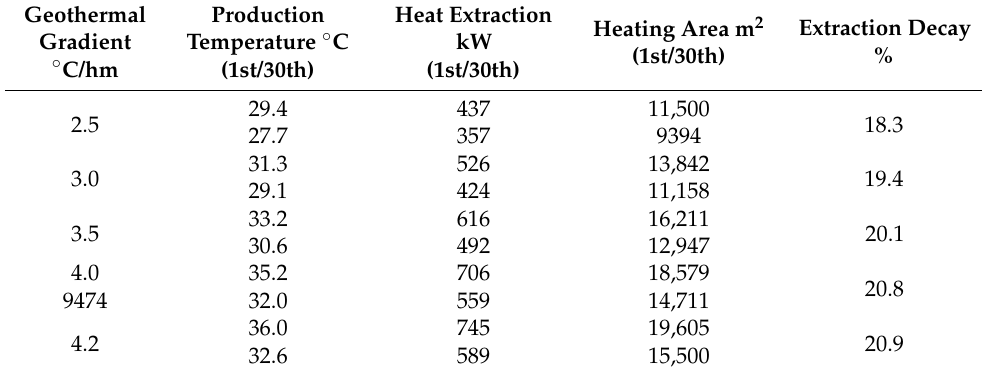
Table 4. Simulation results of M2 well under different geothermal